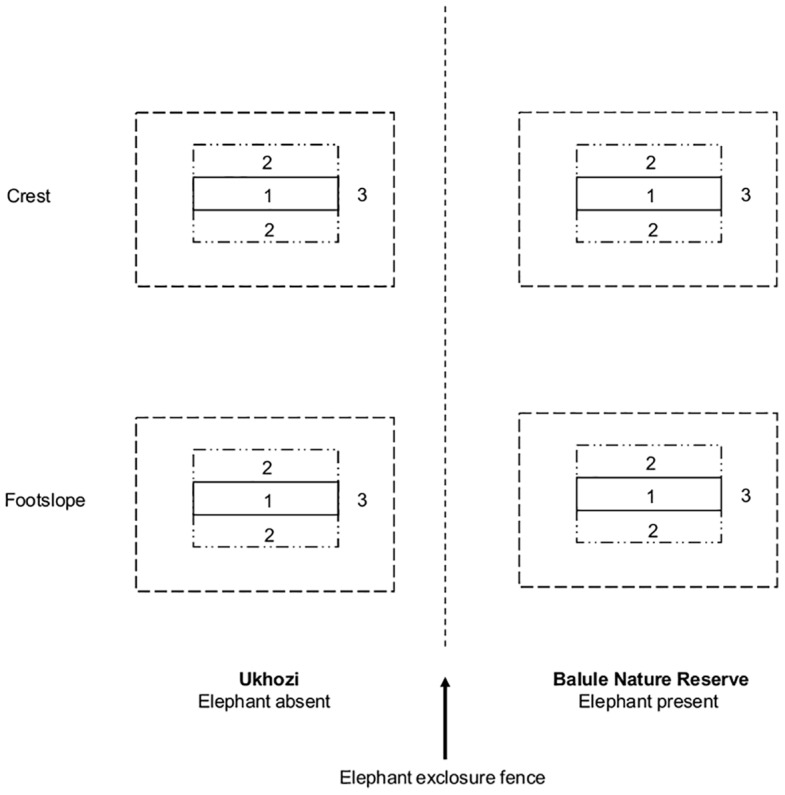
Schematic overview of the four treatments (slope position: footslope vs. crest; elephant: absent vs. present) as laid out on each of the five sites.Vegetation within each treatment was recorded using three quadrats: (1) seedlings only: ≤ 0.5 m; (2) woody individuals above 0.5 m; (3) species not encountered in either quadrat 1 or 2 (all height classes included).